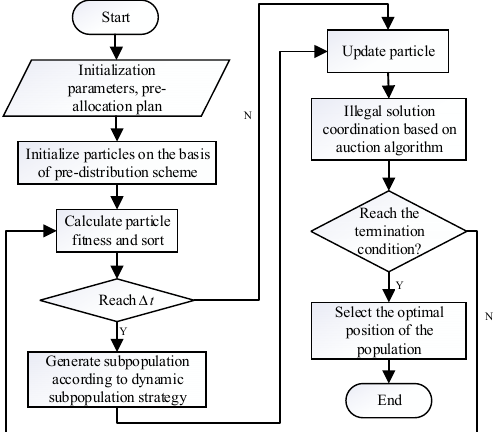
Figure 5. The flow process of the A-QCDPSO algorithm.